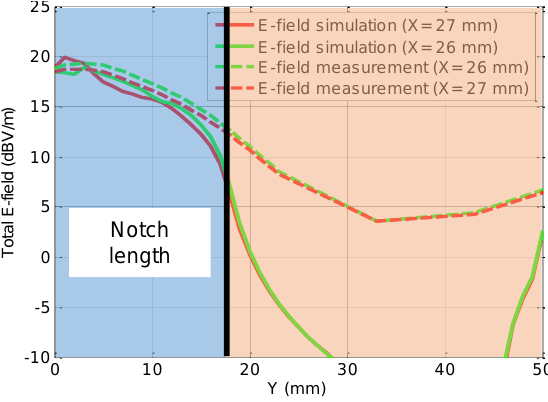
Figure. 12. E-field (dBV/m) along the notch at 560 MHz